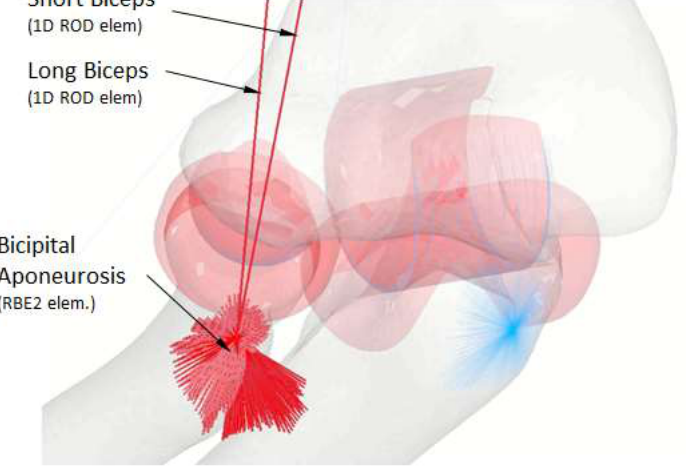
Figure 5. Biceps tendon insertion using RBE2 element.